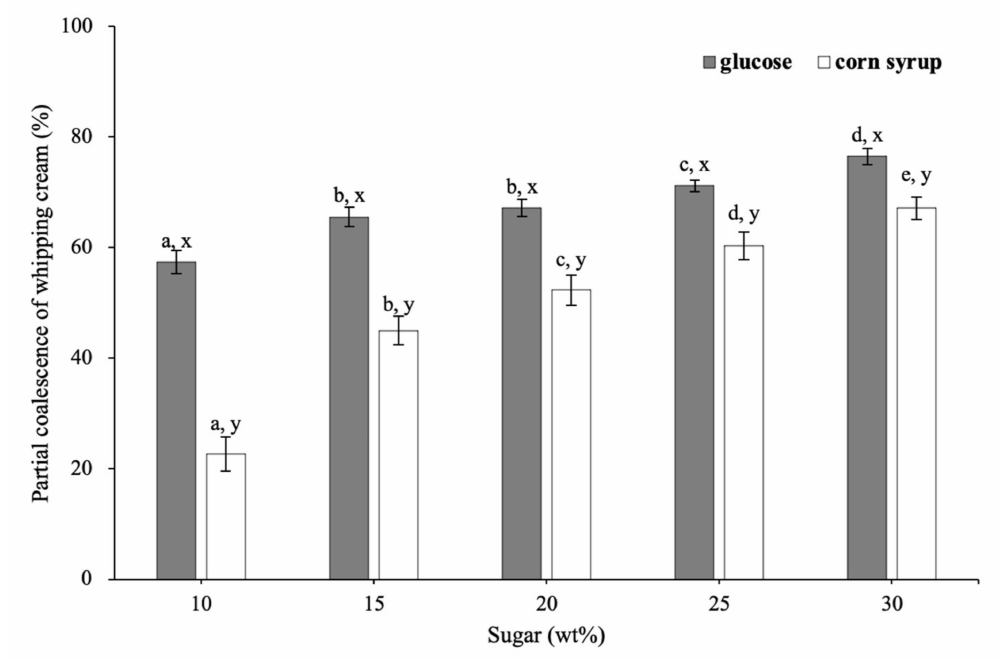
Figure 5. Partial coalescence of whipped creams at different sugar concentrations. Different letters of a–e on the top of columns represent significant differences ( p < 0.05) among the various sugar levels. Different letters of x, y on the top of columns represent significant difference ( p < 0.05) between glucose and corn syrup in the same